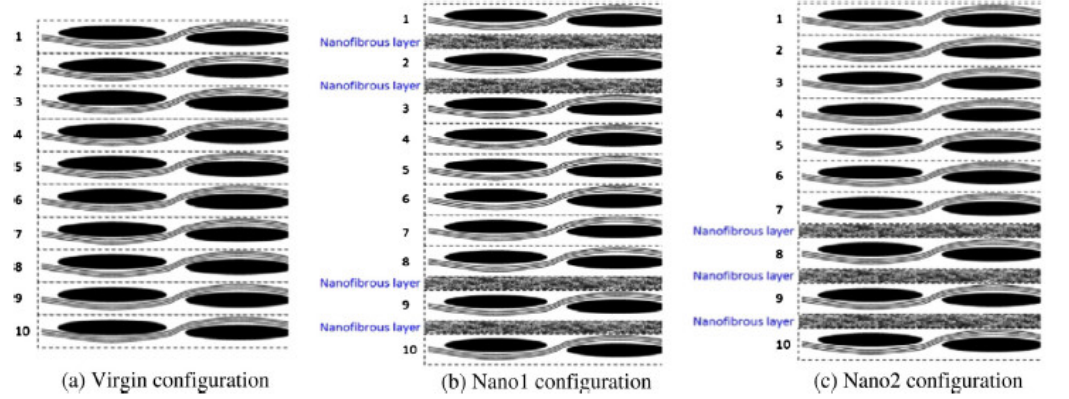
Figure 3. Two different configurations for interleaving carbon/epoxy laminates [27] .